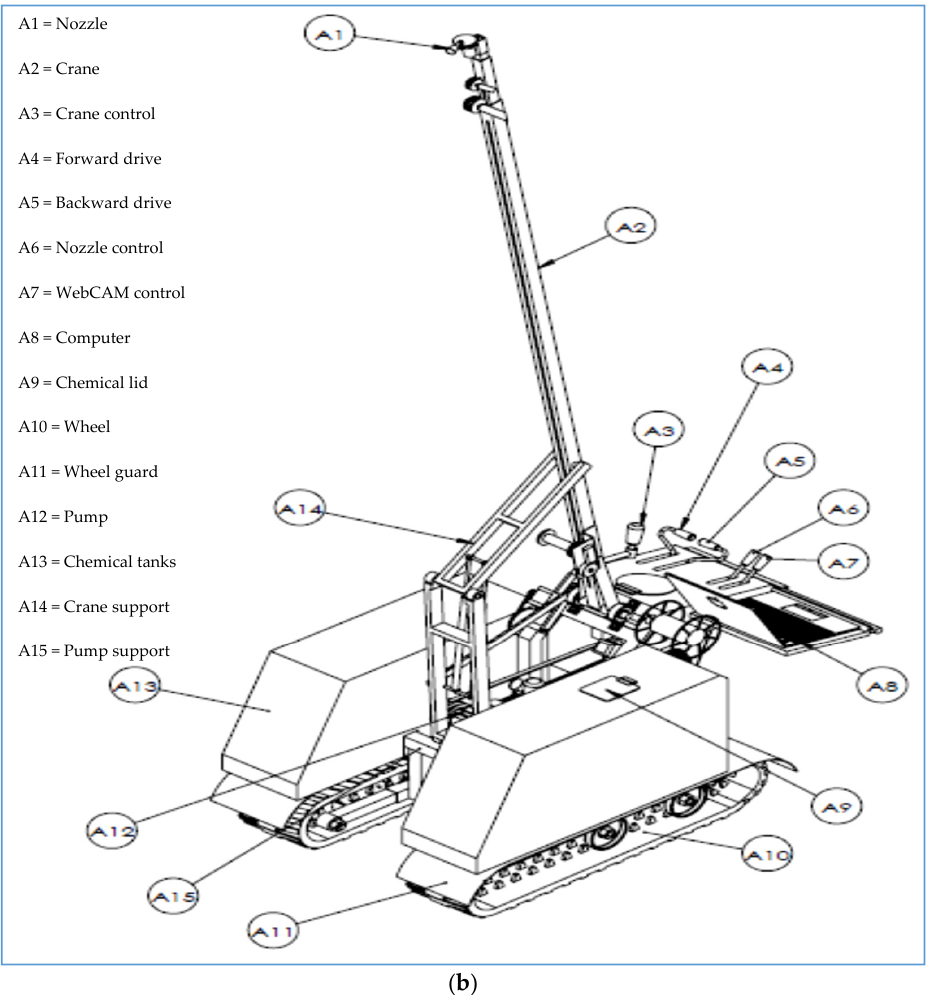
Figure 1. Instrumentation and overall procedural configuration; ( a ) Variable rate spraying system is a flow-based control of chemical application rate; ( b ) Isometric view of variable rate sprayer with remote sensing system.